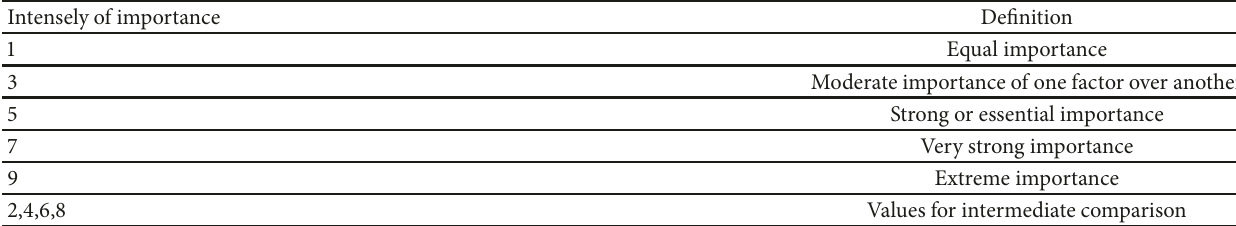
Table 5: Saaty’s scale for pairwise